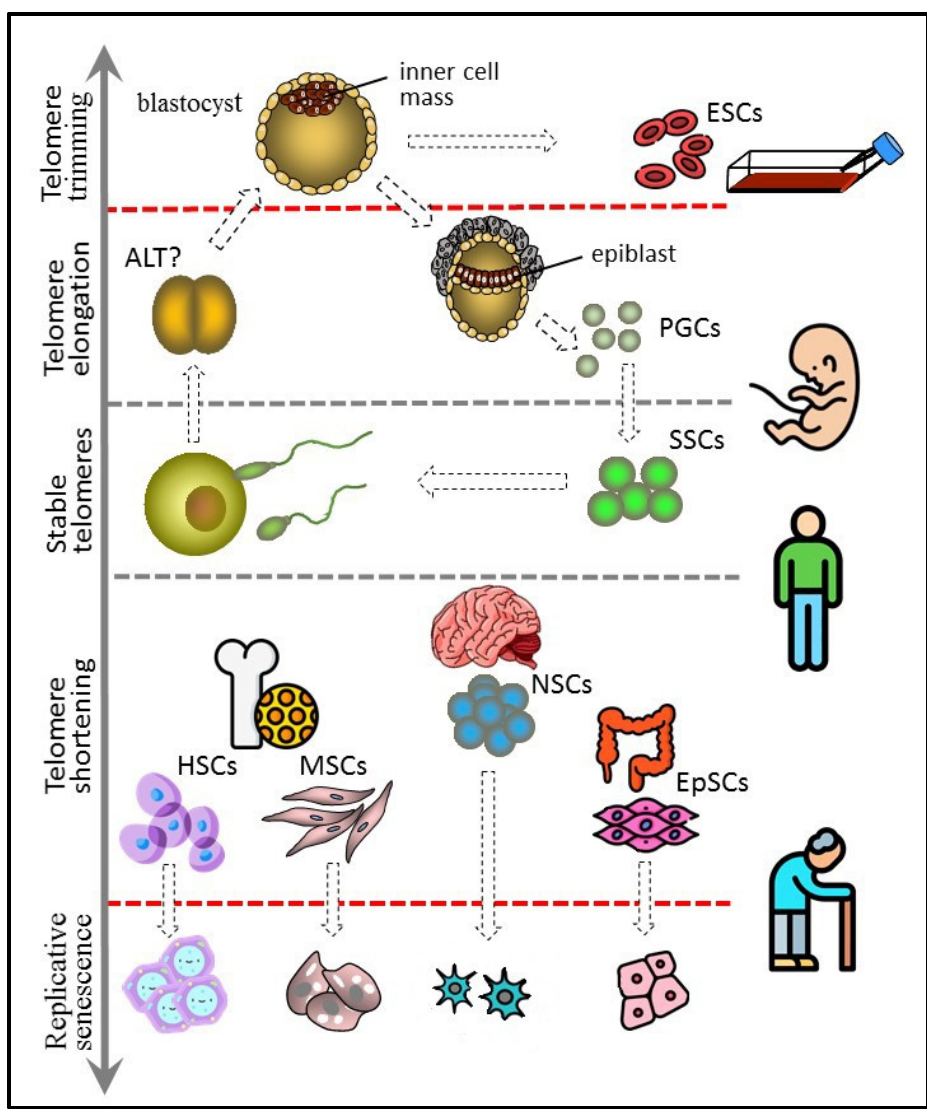
Figure 4. Telomere length dynamics in various types of stem cells.